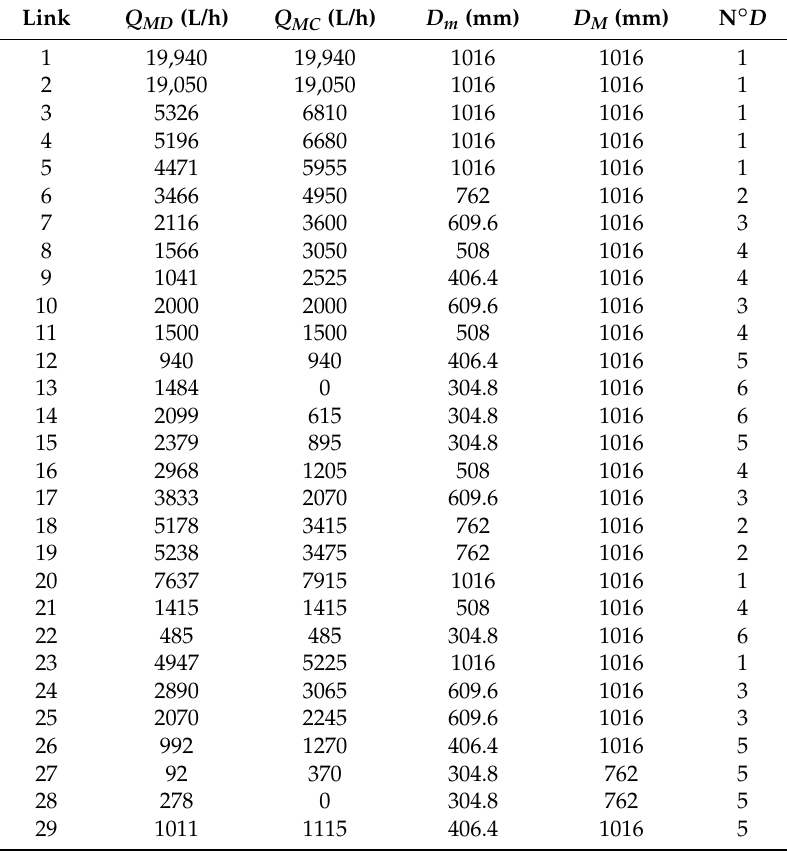
Table 3. Flow range, maximum and minimum diameters and number of possible diameters for each link obtained from the QPPs for the Hanoi